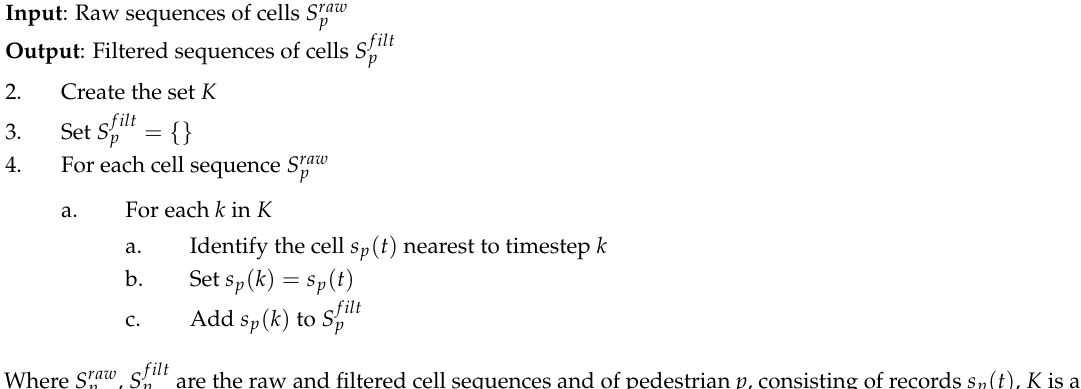
Algorithm 3: Description of the first hit algorithm, which translates the raw cell sequence to a cell sequence of cells that were first visited in each time